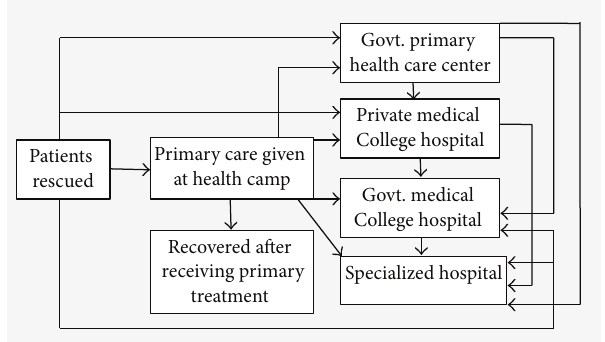
Figure 2: Referral system practiced during the Savar disaster.